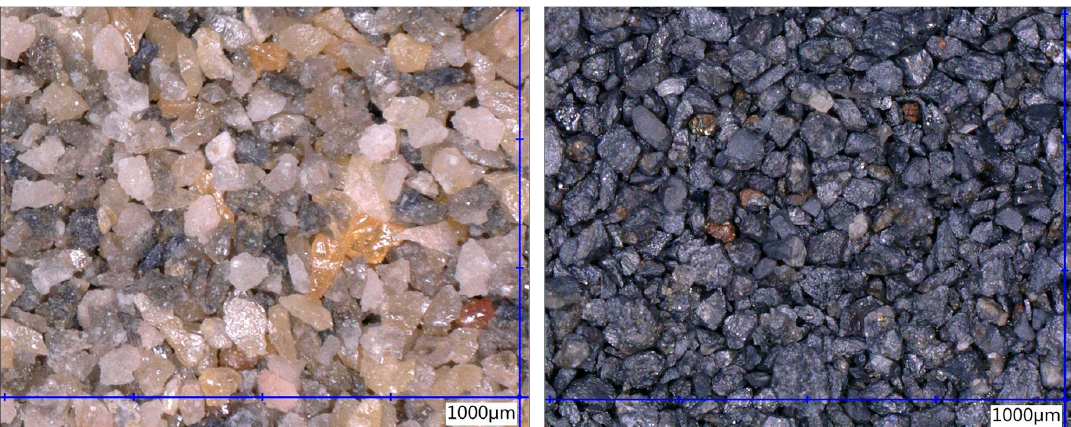
Figure 11. Microscopic images of non-magnetic fraction ( left ) and coronadite product ( right ) after magnetic separation.